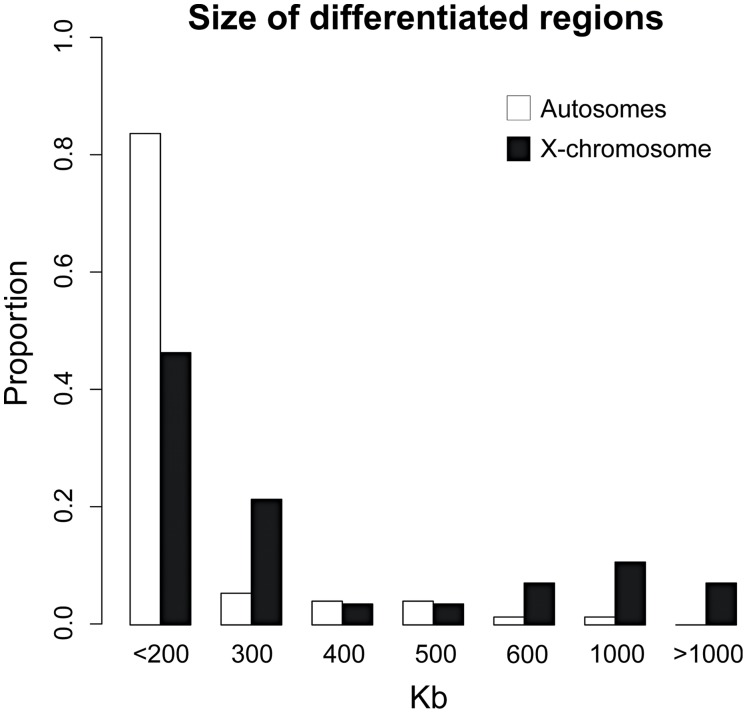
Highly heterogeneous size of differentiated regions.Histogram summarizing the physical size (Kb) of independent regions of differentiation between rabbit subspecies.